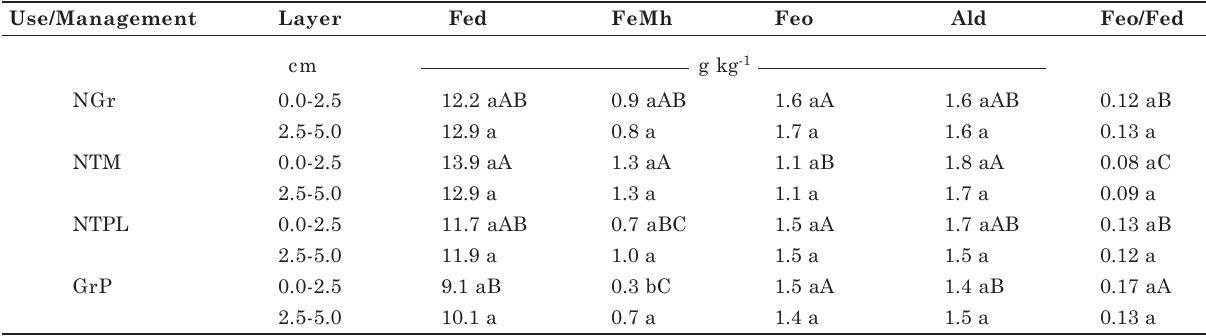
Table 5. Iron and aluminum concentrations extracted from two layers of a Rhodic Paleudult under four land use and management systems